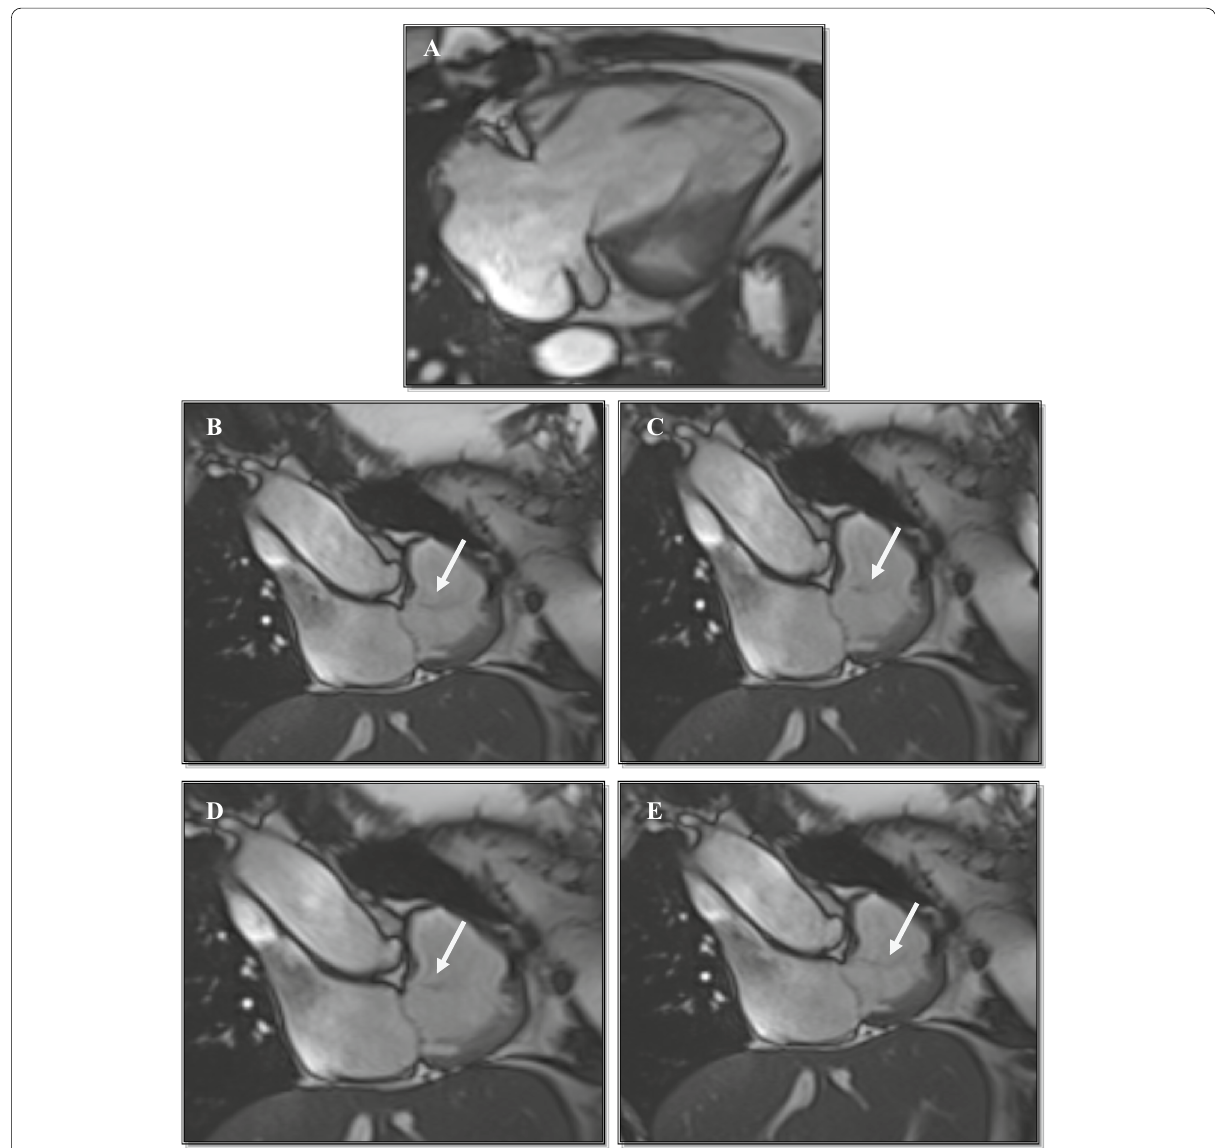
Fig. 1 A – M CMR revealed: Dilated RV, moderate PS (Venc 3.5 m/s), mild PR, RF 17%, mild AR, Qp/Qs 1.4 denoting residual left right = = = → shunt, dilated RA. A 49-year-old female patient, diagnosed as tetralogy of Fallot, underwent RVOT repair at age of 12-year-old. The patient was referred for RV volumes, function and Qp/Qs quantification. A Right 2-chamber cine image at diastole showing dilated, non-hypertrophied right ventricle. B , C , D , E Four sequential images right in-flow/ out-flow cine stack showing residual VSD jet. F Sagittal pulmonary phase-contrast velocity encoding sequence (in-plane, Venc 1.5 m/s); phase image showing aliasing at the pulmonary valve level requiring increasing the Venc till aliasing disappears. G Coronal pulmonary phase-contrast velocity encoding sequence (in-plane, Venc 2 m/s); phase image showing still noted aliasing at the pulmonary valve level requiring increasing the Venc till aliasing disappears. H , I Coronal pulmonary phase-contrast velocity encoding sequence (in-plane, Venc 3.5 m/s); magnitude and phase images showing disappearance of the aliasing at the pulmonary valve level denoting peak systolic velocity at this level (3.5 m/s) with pressure gradient 49 mmHg calculated by modified Bernoulli equation. J Pulmonary phase-contrast velocity encoding sequence (through-plane with Venc 3.5 m/s); phase image showing no aliasing denoting optimum Venc. K Phase-contrast velocity encoding sequence (through-plane sub-aortic level with Venc 1.5 m/s); phase image showing regurgitant blood flow for better assessment of regurgitant blood volume and therefore better assessment of regurgitant fraction, in which Qp/Qs can be calculated and found to be equal to 1.4:1 denoting left to right shunt, validating the appearance of residual VSD in the cine images. L Sagittal pulmonary cine image at diastole showing dephasing jet of pulmonary regurgitation (PR). M Feature-tracking analysis of 4-chamber cine image with endocardial contouring of dilated right atrium, RA GLS (10%) being lower than normal right atrial longitudinal strain range documented in this study (Min–Max =